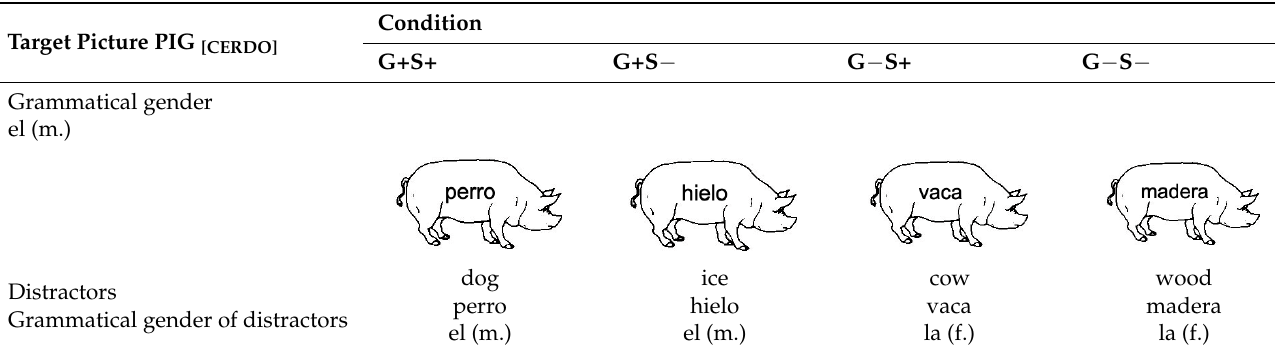
Table 1. Sample of stimuli in the experimental session for the PWI task.